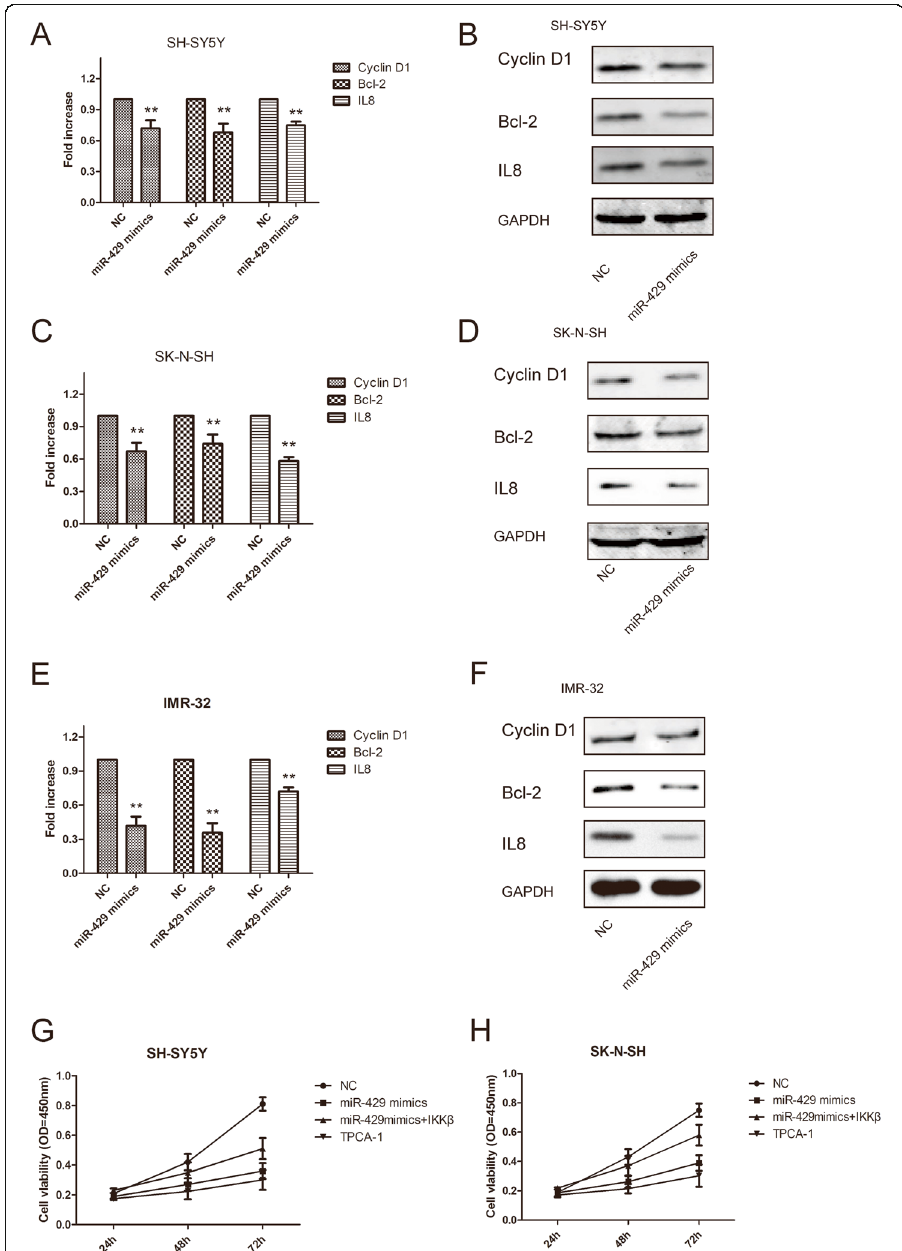
Fig. 5 MiR-429 inhibited the NF- κ B pathway. a , c and e – Relative mRNA expression of NF- κ B-regulated genes in SH-SY5Y ( a ), SK-N-SH ( c ) and IMR-32 ( e ) cells. GAPDH was used as a loading control. b , d and f – Western blot showing NF- κ B-regulated gene protein expression levels in SH-SY5Y ( b ), SK-N-SH ( d ) and IMR- 32 ( f ) cells. g and h – Overexpression of IKK β attenuated the anticancer effect of miR-429 in SH-SY5Y and SK-N-SH cells. Error bars represent the mean ± SEM of at least three independent experiments. N.S.: not significant; * p < 0.05 and ** p < 0.01 vs. the control